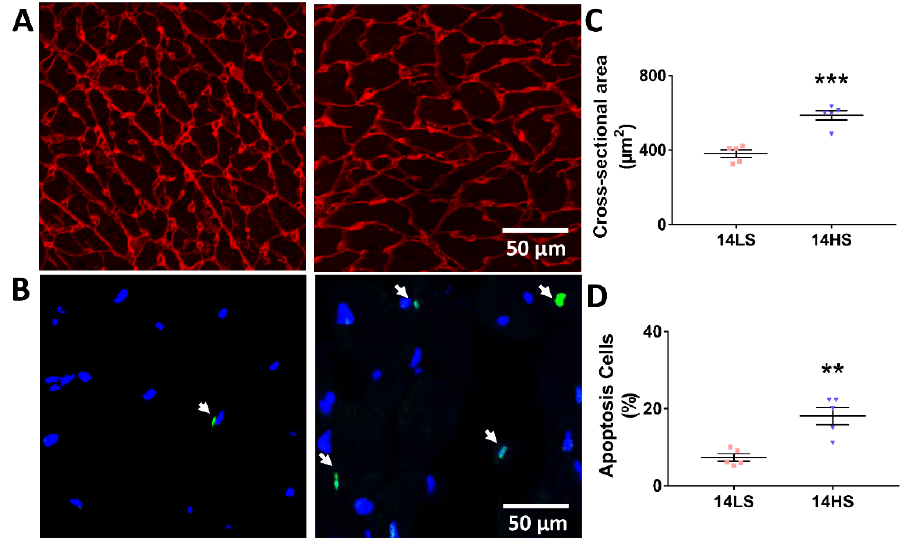
Figure 4. Histological evaluation showed increase in size and apoptosis of myocytes of HS-fed DSS rats. ( A , B ) Representative immunofluorescence images of myocytes stained by WGA and TUNEL (arrow refers to apoptotic cells) and ( C , D ) cross-sectional area of a myocyte and apoptosis rate (TUNEL-positive nuclei as percentage of total nuclei) in the two groups at the age of 14 weeks ( n = 5 for each group). ** p < 0.01, *** p < 0.001.